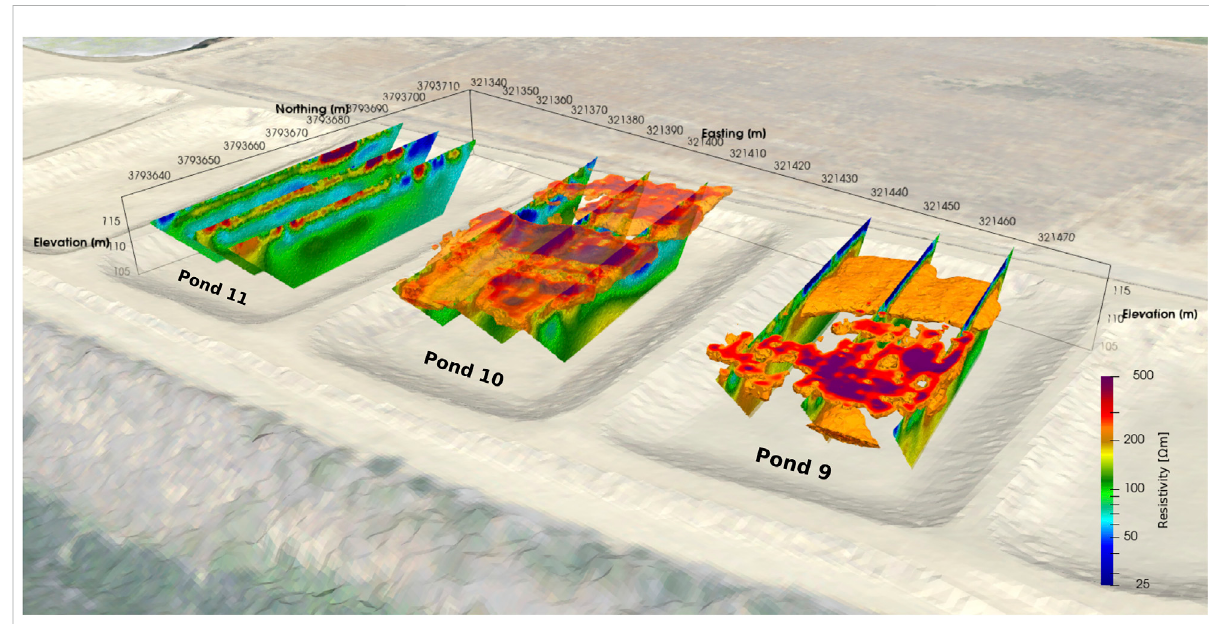
FIGURE 3 Electrical resistivity models obtained from the ERT data inversion. Shown are slices through the 3D models for ponds 9 and 10, and the 2D pro fi les that were acquired in pond 11. For ponds 9 and 10, resistivities > 200 Ω m are shown in 3D, which represent a sandy layer. Note that at the northern part of pond 9, this layer is overlain by a thick layer of low resistivity sediments. Inversions converged to χ 2 =